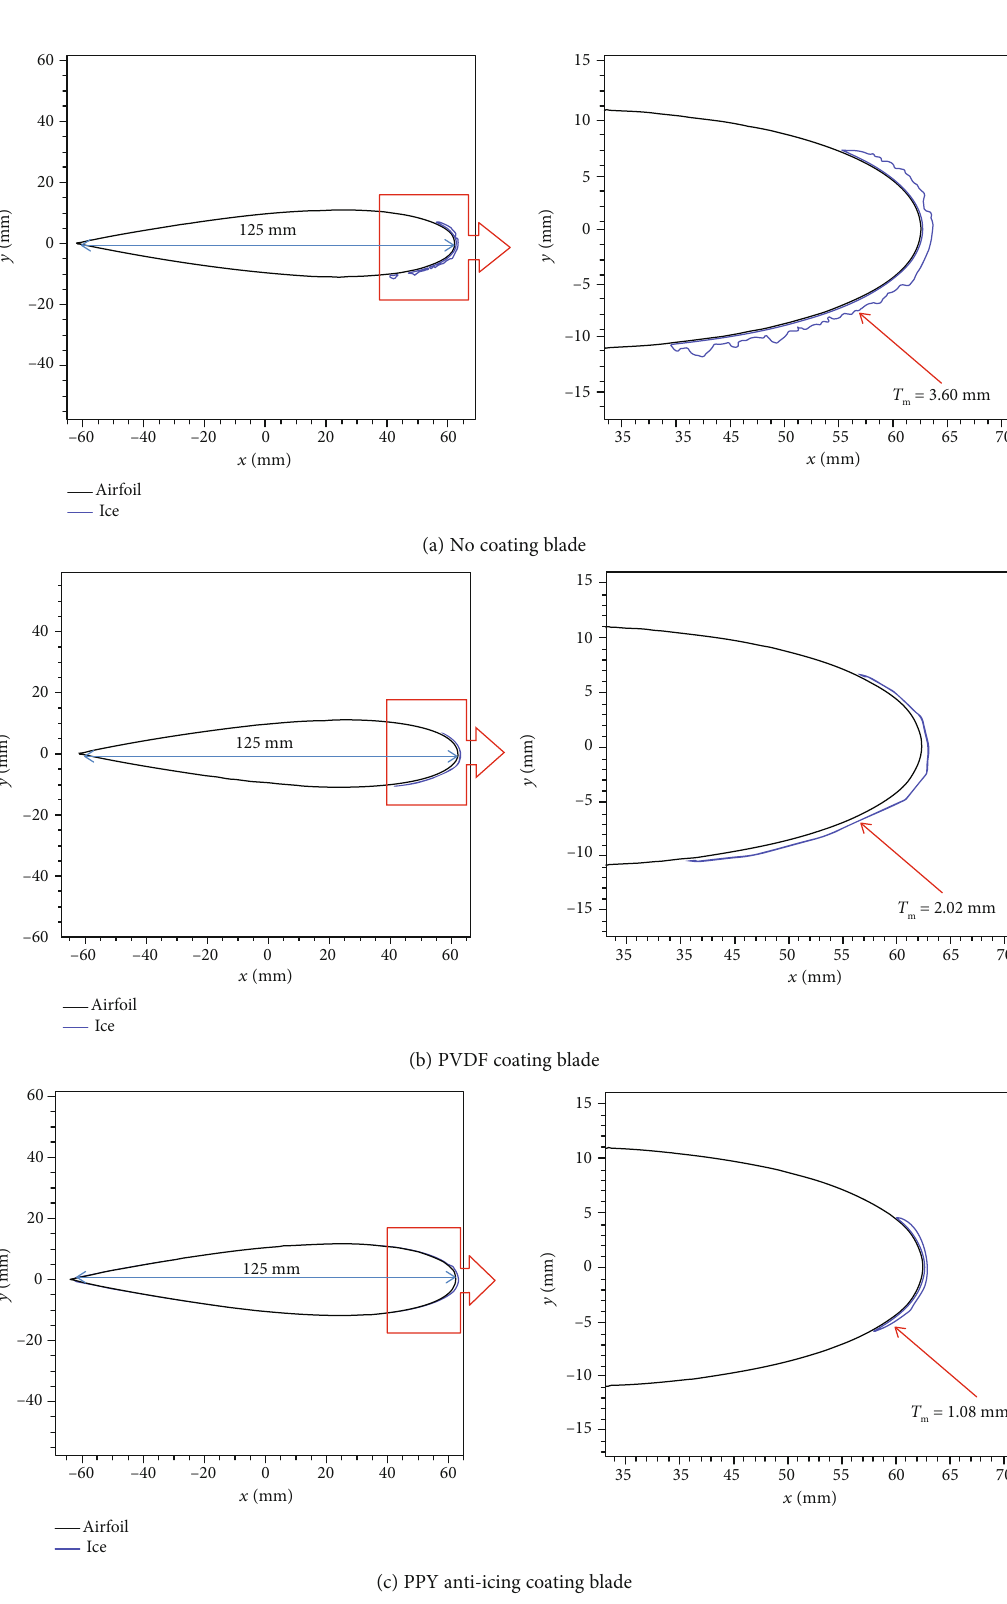
Figure 10: The results of icing on three kinds of blade